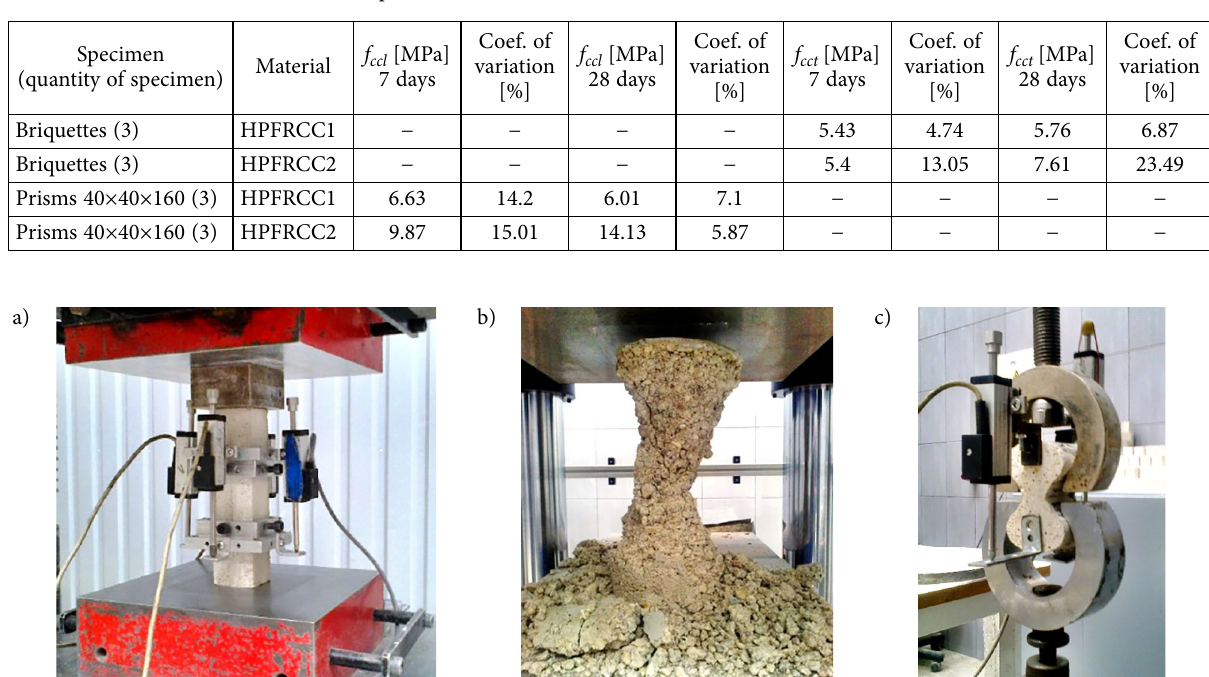
Figure 3. Material specimens during test: (a) – high strength concrete prism; (b) – concrete cylinder; (c) – briquette specimen at direct tension test